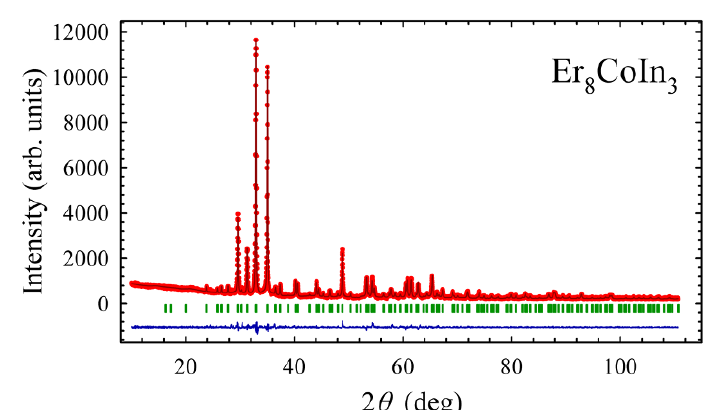
Figure 4. Observed ( ۰ ) calculated (‘) and difference X-ray diffraction patterns of the Er